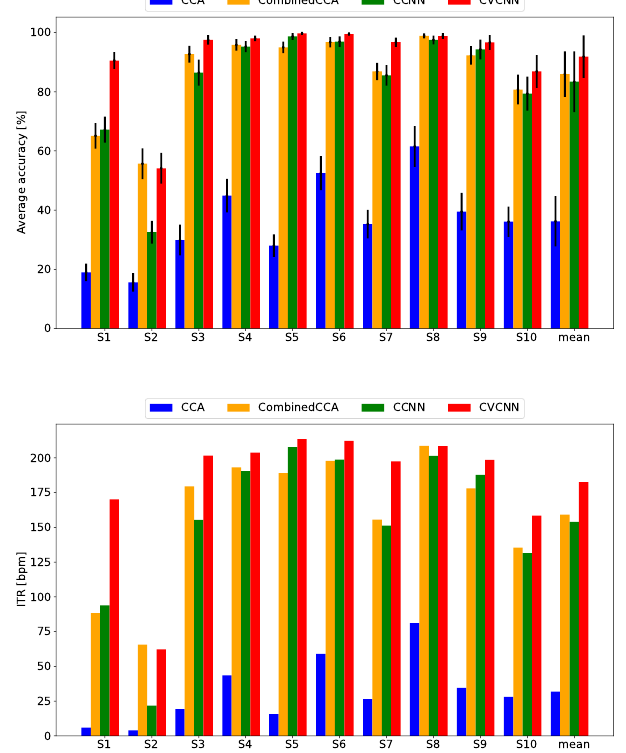
Figure 7. Classification accuracy and ITR for teh open dataset with a data length of 500